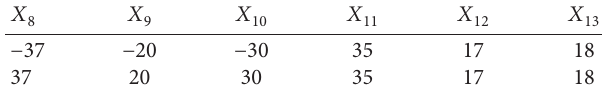
Table 16: Model-free checks with edge plan in Table